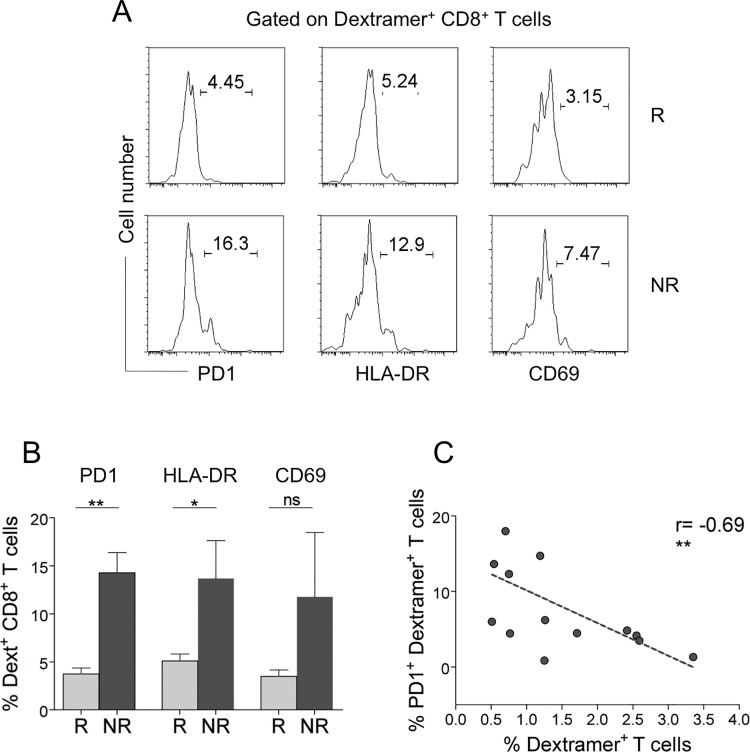
Expression of activation markers by AE-specific CD8+ T cells in Rs and NRs (A-C).(A) Representative flow cytometry analysis of PD-1, HLA-DR, and CD69 in AE-specific dextramer+CD8+ T cells from an R and an NR. (B) Percentage of AE-specific dextramer+CD8+ T cells expressing PD-1, HLA-DR, or CD69 in all Rs and NRs studied. Statistical analysis was performed with the Mann-Whitney test. *P < 0.01; **P < 0.001; ns = not significant. (C) Correlation between AE-specific dextramer+CD8+ T cells expressing PD-1 and total AE-specific dextramer+CD8+ T cells (Spearman correlation analysis). **P < 0.001. Analyses were performed at time 0 (before the start of therapy).